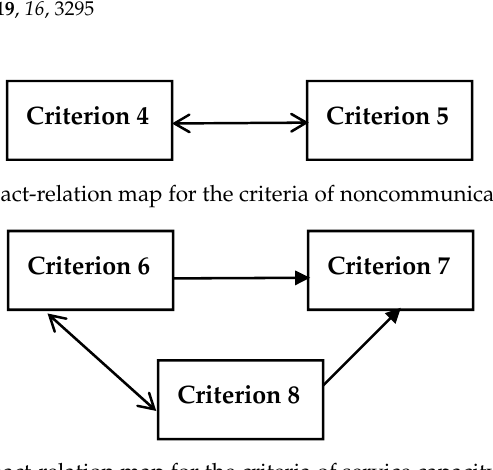
Figure 5. Impact-relation map for the criteria of service capacity and access.